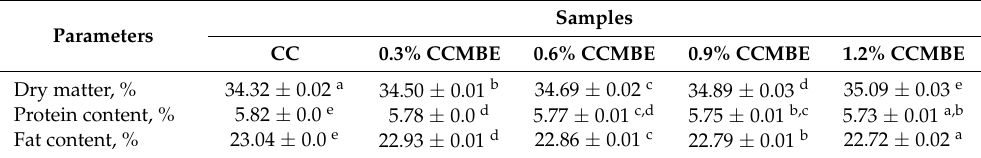
Table 3. Physicochemical parameters of cream cheese fortified with microencapsulated basil